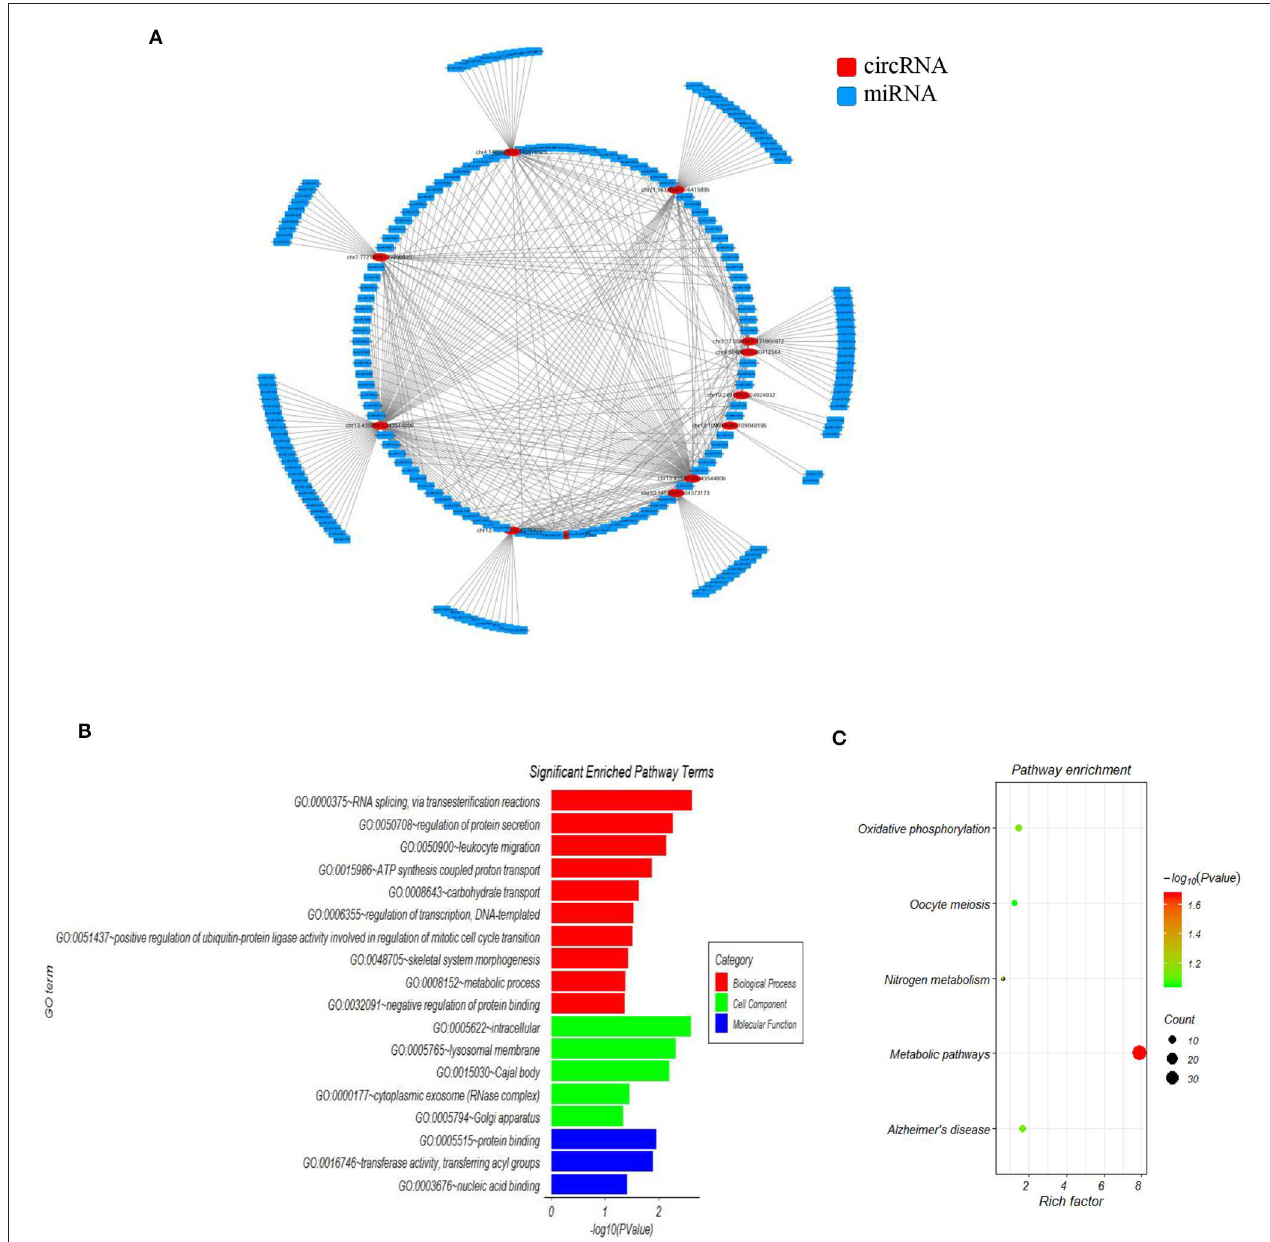
FIGURE 2 | The mapping network of circRNA-miRNA interactions in SLE. (A) The network map includes the 12 surviving candidates from the 15 significantly altered circRNAs (represented as red nodes) in the analysis for circRNA-miRNA network prediction. The other three differentially expressed circRNAs did not show reliable results in this interaction analysis. The blue nodes around the red node were the predicted miRNAs that interacted with the related circRNAs. (B) Gene ontology (GO) analysis for 12 circRNA-interacting miRNAs and their target genes showing significantly enriched pathways. Red indicates biological process (BP), green indicates molecular function (MF), and blue indicates cellular component (CC). (C) KEGG Pathway analysis for 12 circRNA-interacting miRNAs and their target genes showing significantly enriched signaling pathways. The Y-axis indicates pathway name, and the X-axis indicates the richness factor. The size of the spots represents the number of enriched differential target genes, and change of color from green to red represents the